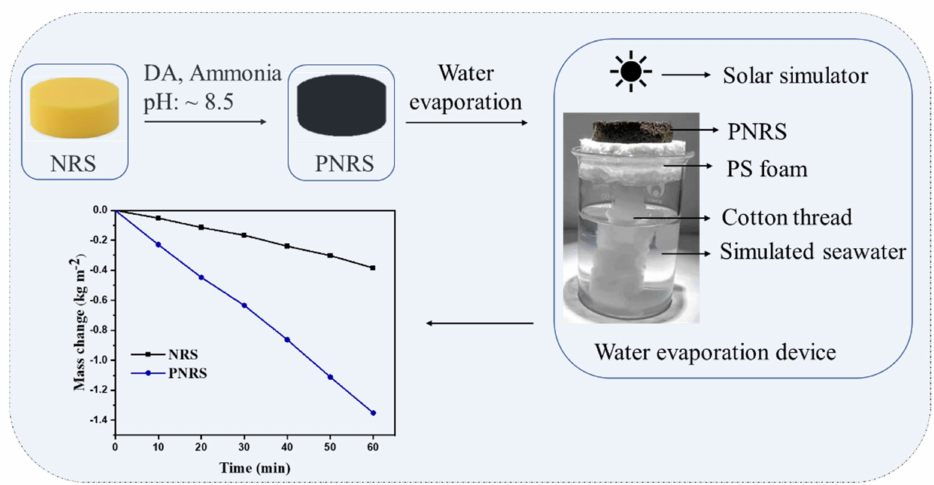
Figure 1. Process of solar evaporation of